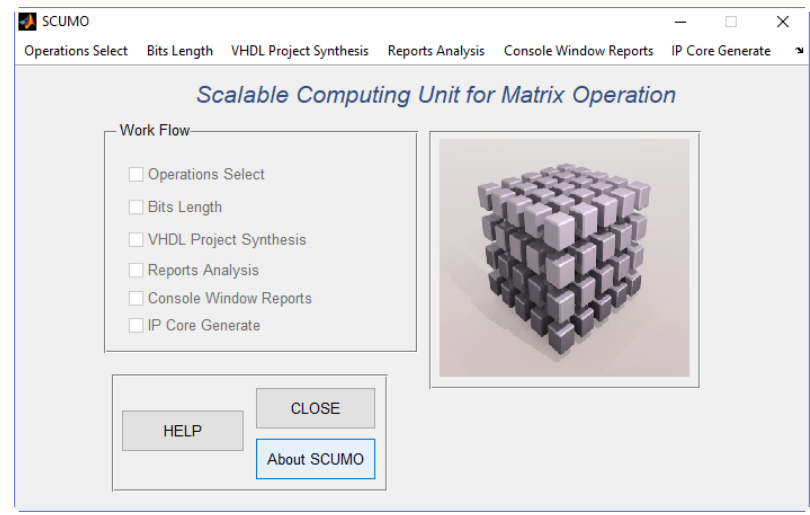
Figure 4. MATLAB GUI interface for the SCUMO